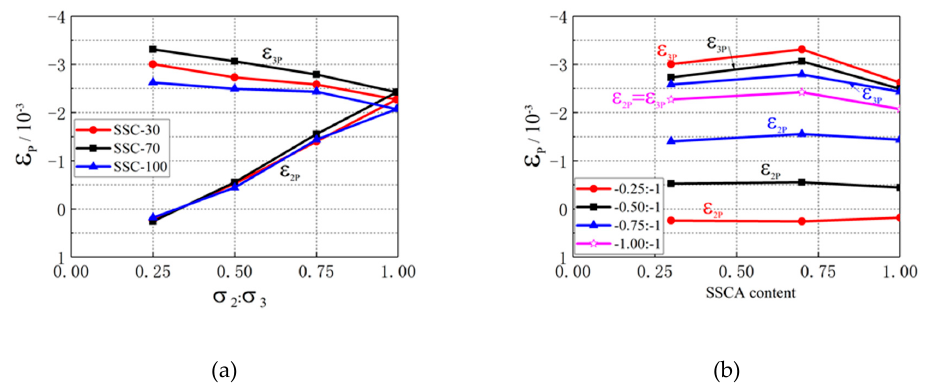
Figure 6. Influence of stress ratio and SSCA replacement ratio on ε 3 p and ε 2 p . ( a ) ε 3 p and ε 2 p with di ff erent stress ratios; ( b ) ε 3 p and ε 2 p with di ff erent SSCA replacement ratios.